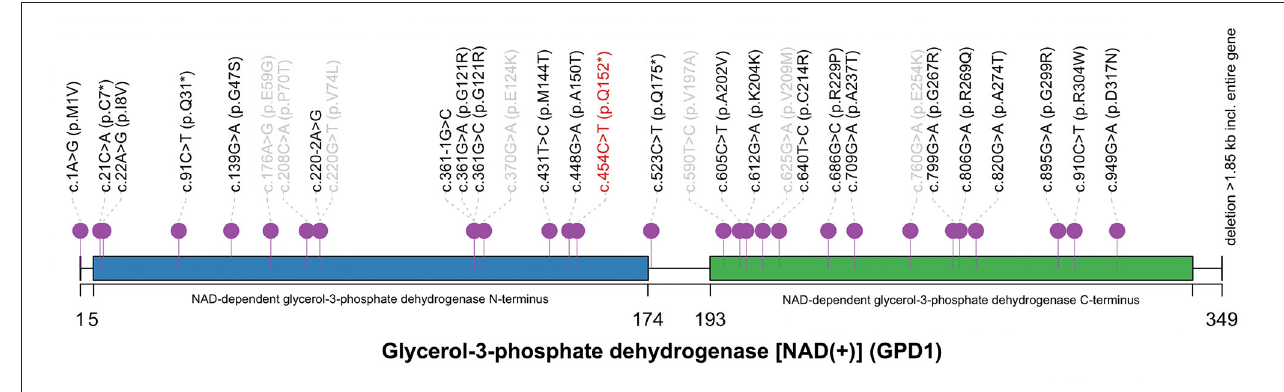
FIGURE 2 | The spectrum of GPD1 mutations reported in HGMD database. The novel variant c.454C > T (p.Q152*) (red) located in NAD-dependent glycerol-3-phosphoate dehydrogenase N-terminus. Twenty-four mutations relevant to HTGTI are marked in black. Seven mutations not associated with HTGTI are labeled in gray. This spectrum was generated by R with trackViewer: lollipopPlot (Ou and Zhu,